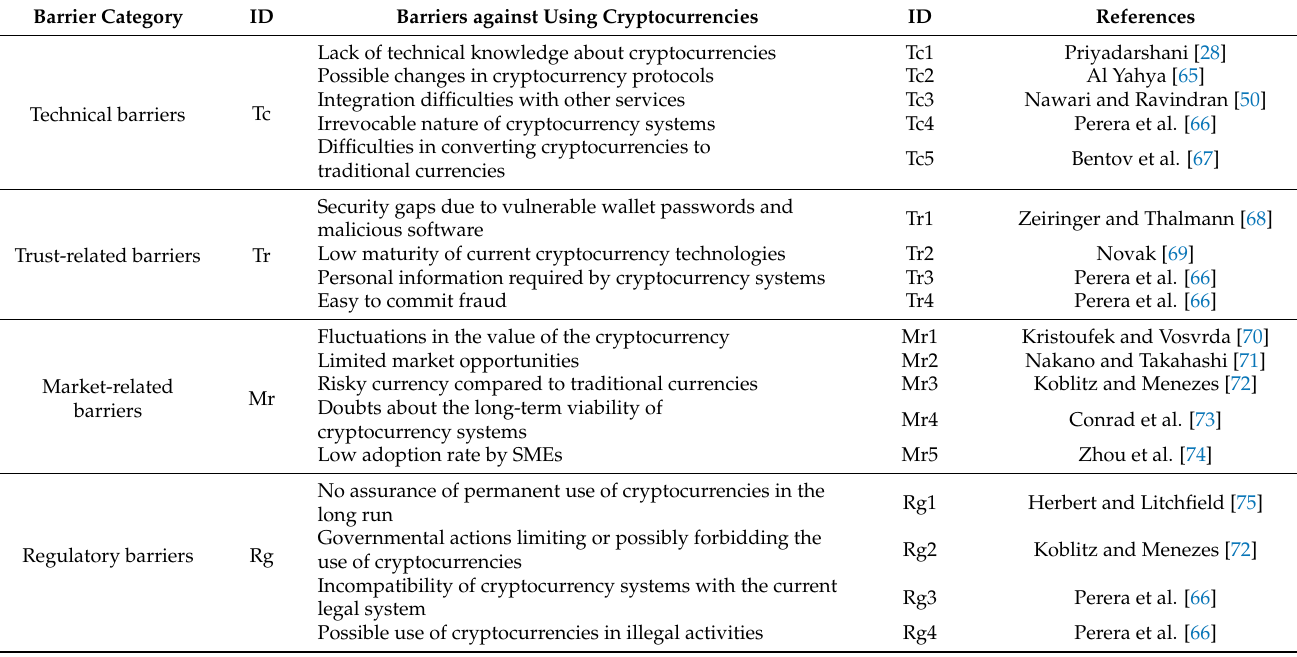
Table 1. Barriers affecting the use of cryptocurrency in construction supply